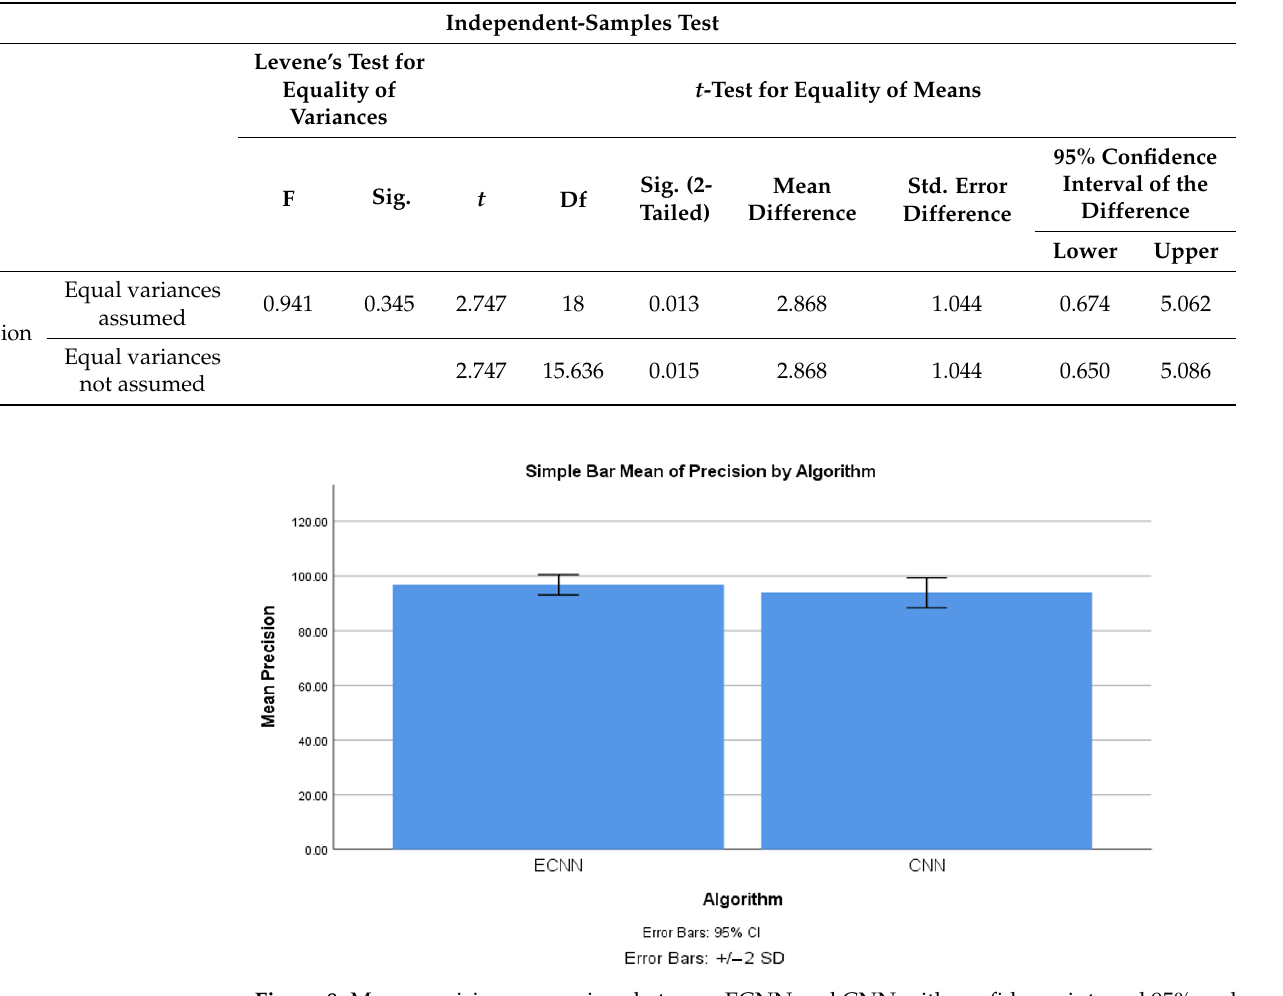
Table 8. Group statistics parameter comparison for false positive between ECNN and CNN.